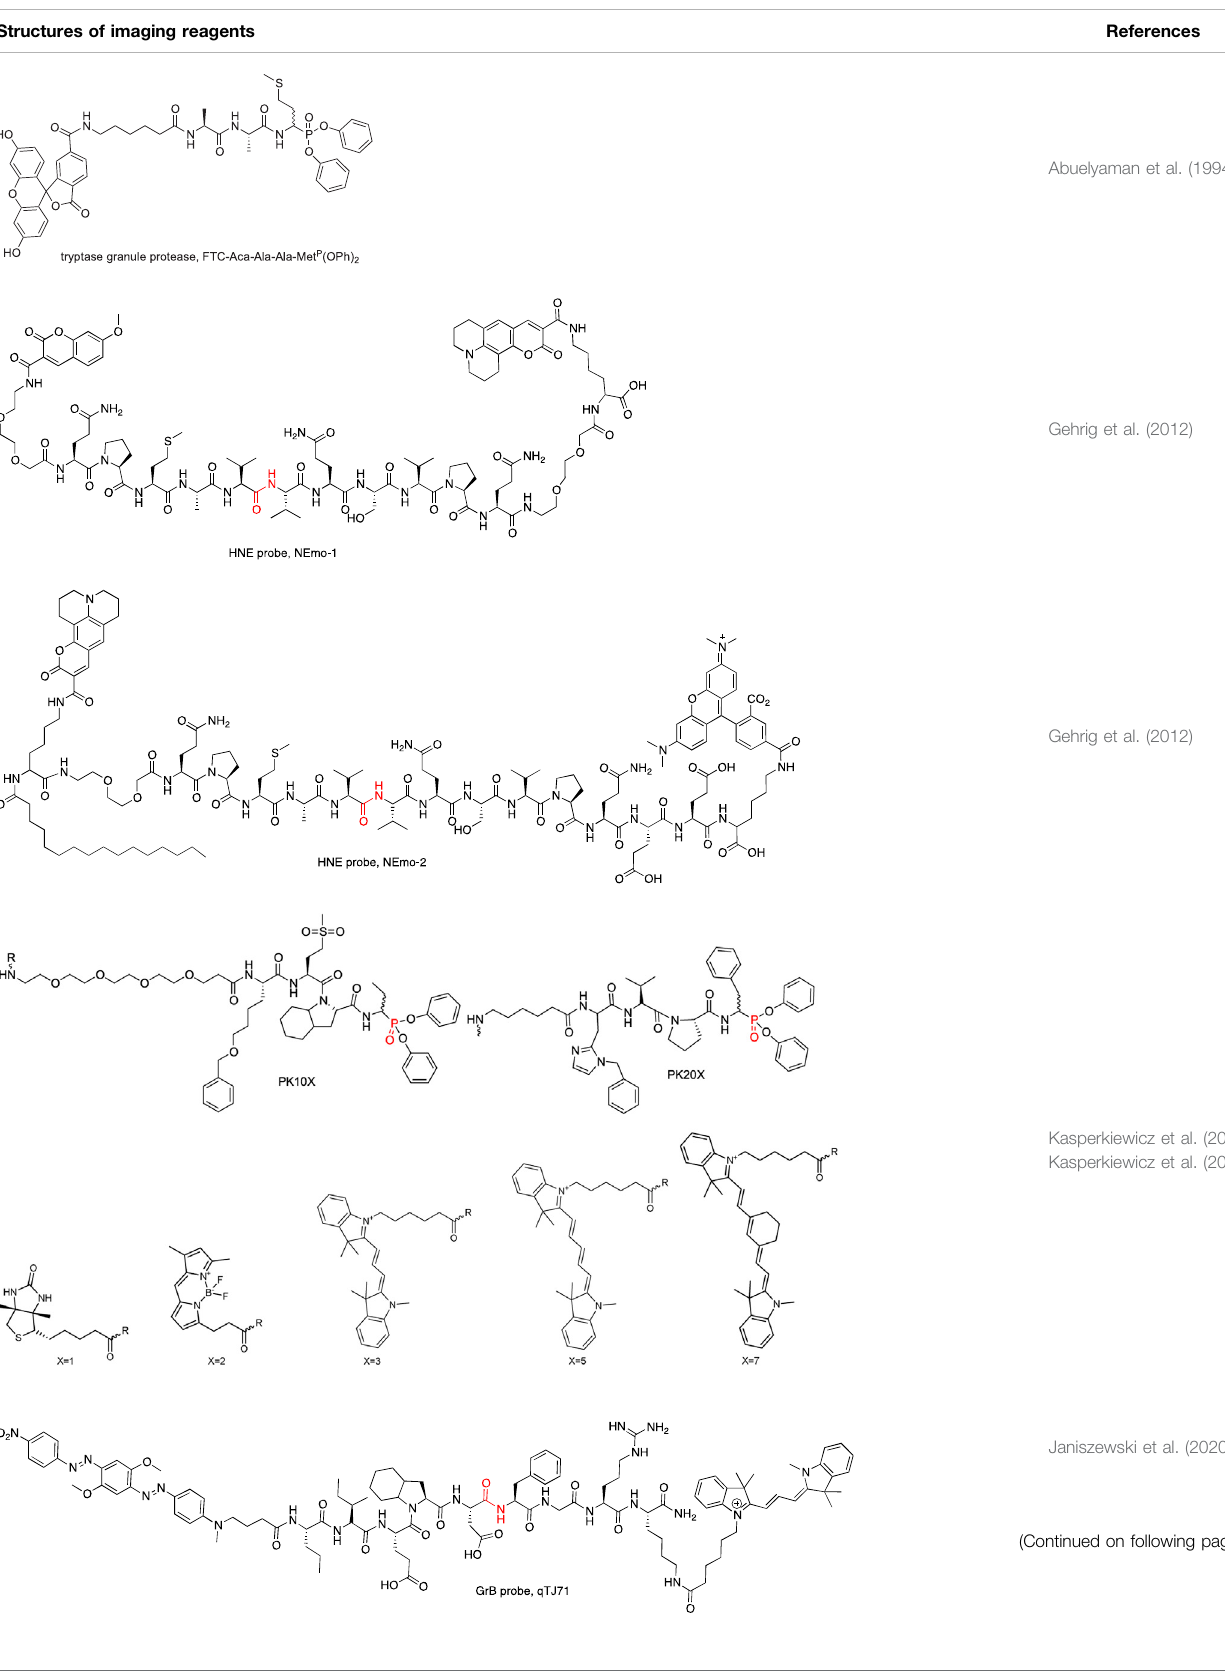
TABLE 3 | Structures of imaging